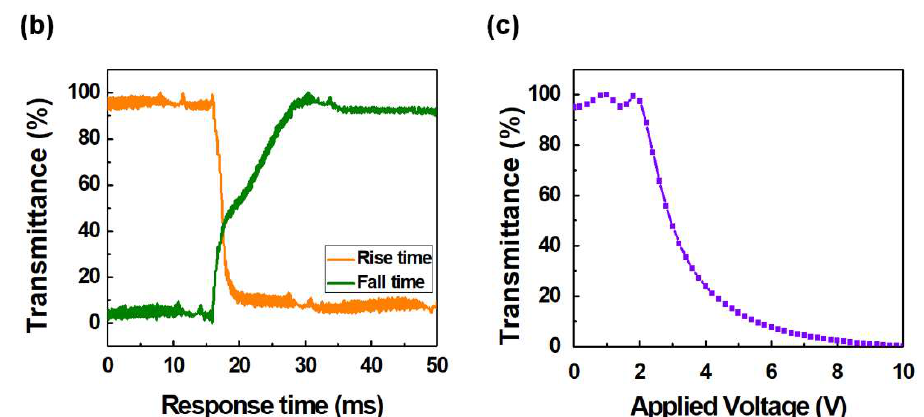
Figure 10. ( a ) Illustration of the operating process of TN-LC cells when a voltage is applied or turned off. EO characteristics of the TN-LC cells fabricated from a brush-coated LaYSrO layer cured at 270 °C: ( b ) response time and ( c ) threshold voltage.